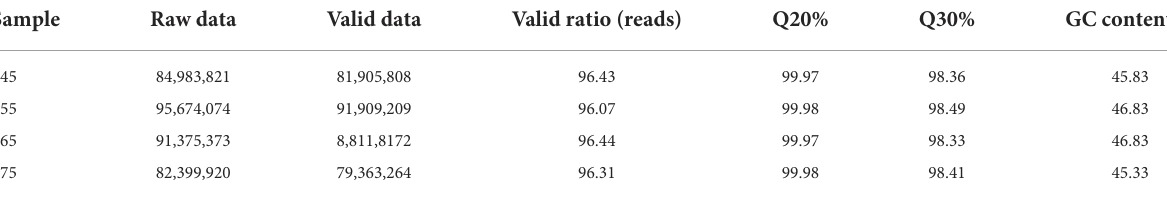
TABLE 1 Data quality control statistics.